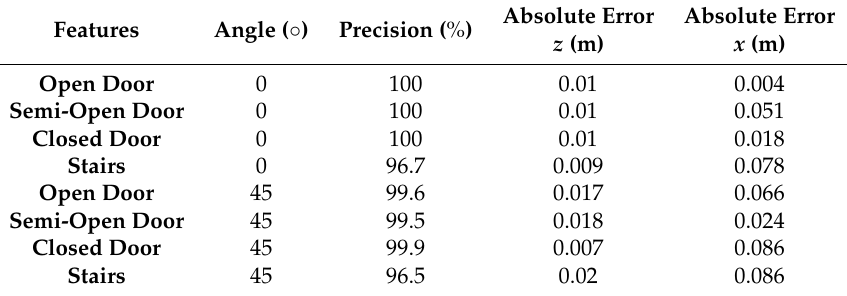
Table 4. Absolute error and